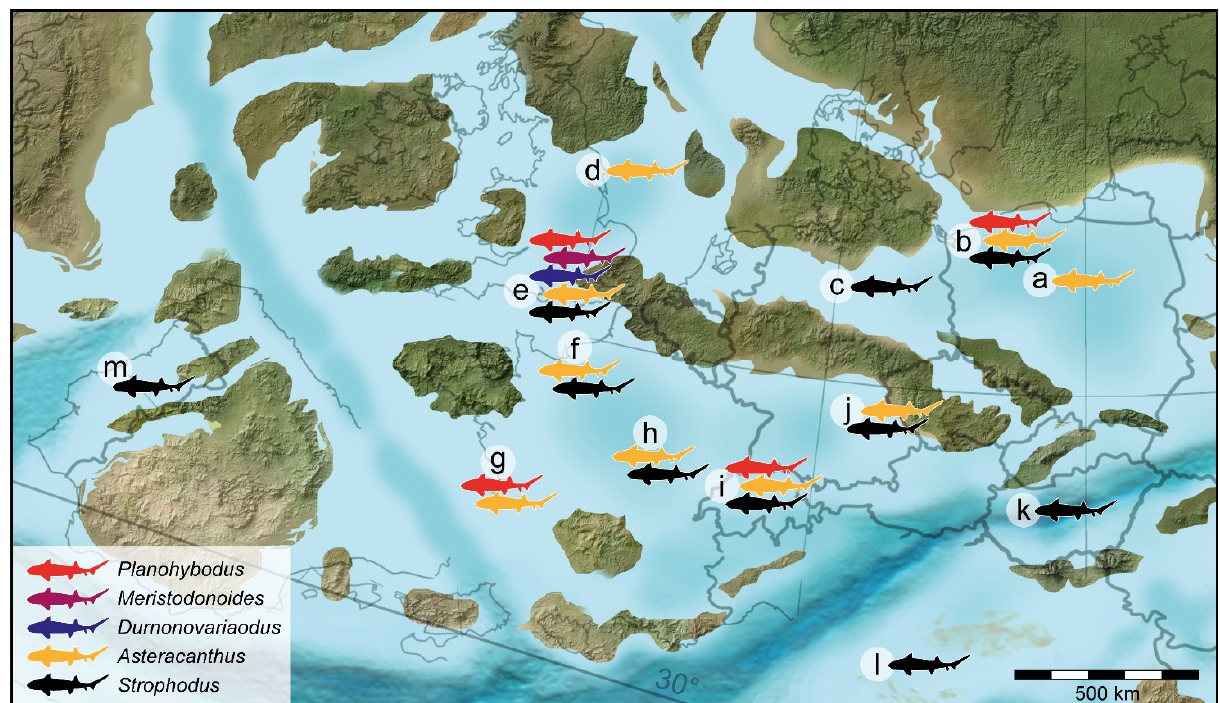
Figure 6. Rough reconstruction of Europe during the Late Jurassic depicting reported occurrences of large-toothed hybodontiform genera (taxa that cannot confidently be identified at genus level are excluded). ( a ) Oxfordian–Kimmeridgian of central Poland [19]; ( b ) Kimmeridgian of north-western Poland (this study); ( c ) Kimmeridgian of northern Germany [17]; ( d ) Oxfordian of northern England [97]; ( e ) Oxfordian–Tithonian of southern England [25,26,30,31]; ( f ) Kimmeridgian of north-western France [20]; ( g ) Tithonian of western France [20,79,80]; ( h ) Oxfordian of central France [98]; ( i ) Kimmeridgian of Switzerland [29]; ( j ) Kimmeridgian of southern Germany [28,30,111]; ( k ) Tithonian of Hungary [92]; ( l ) Kimmeridgian–Tithonian of Italy [105]; ( m ) Kimmeridgian of Portu- gal [21,22]. Palaeogeographic map © 2011 Colorado Plateau Geosystems Inc., Scottsdale, AZ,